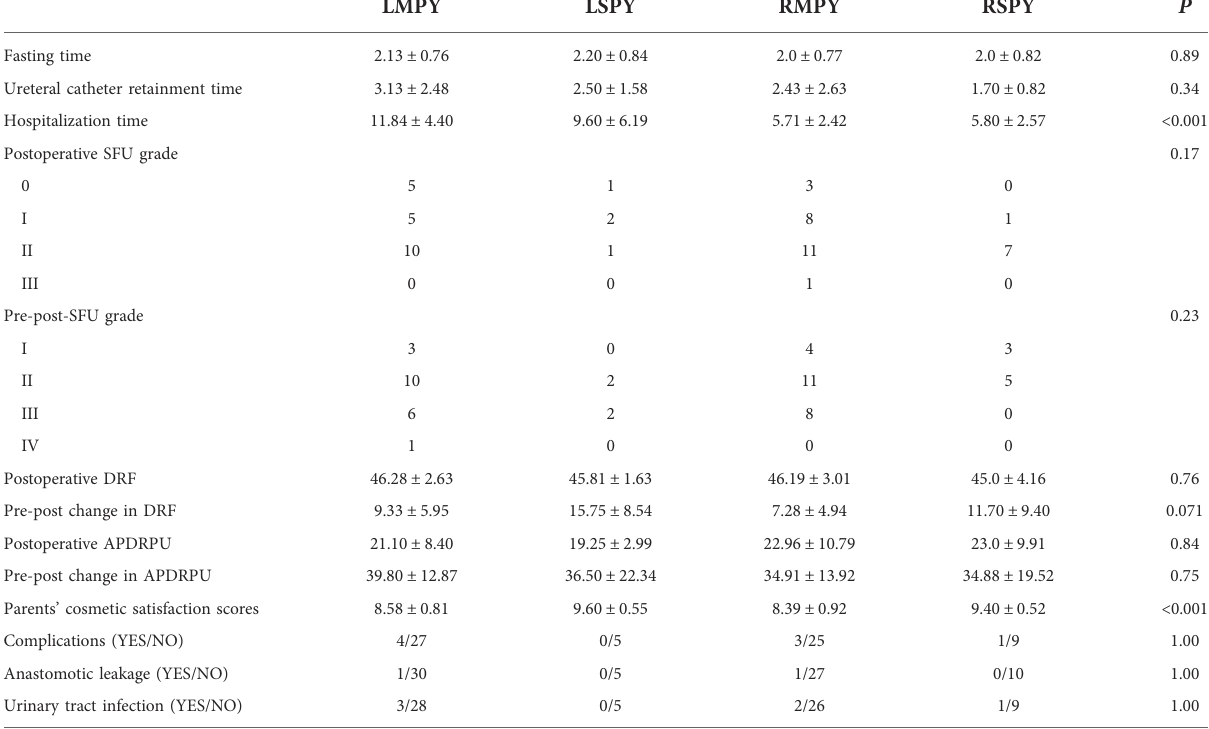
TABLE 3 Patients ’ postoperative follow-up data.